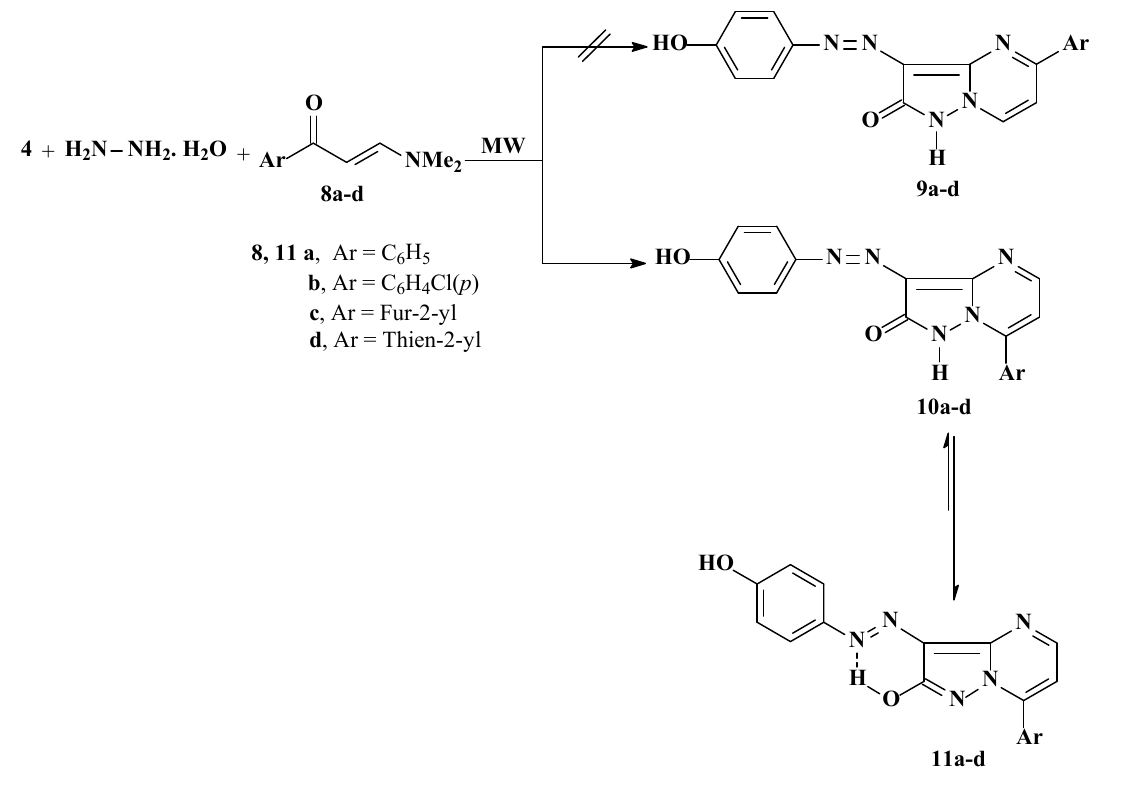
Figure 3. Ortep plot of the X-ray crystallographic structure of 11c